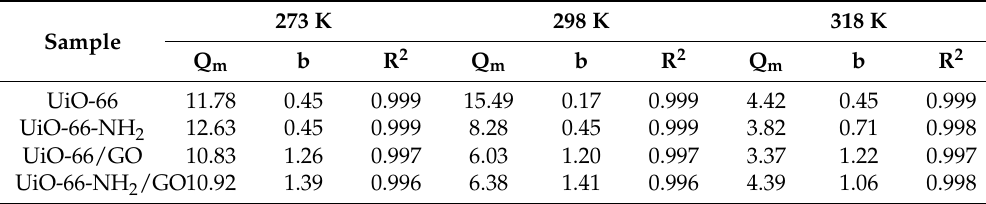
Table 3. Data of Langmuir isotherm for CO 2 adsorption on the different